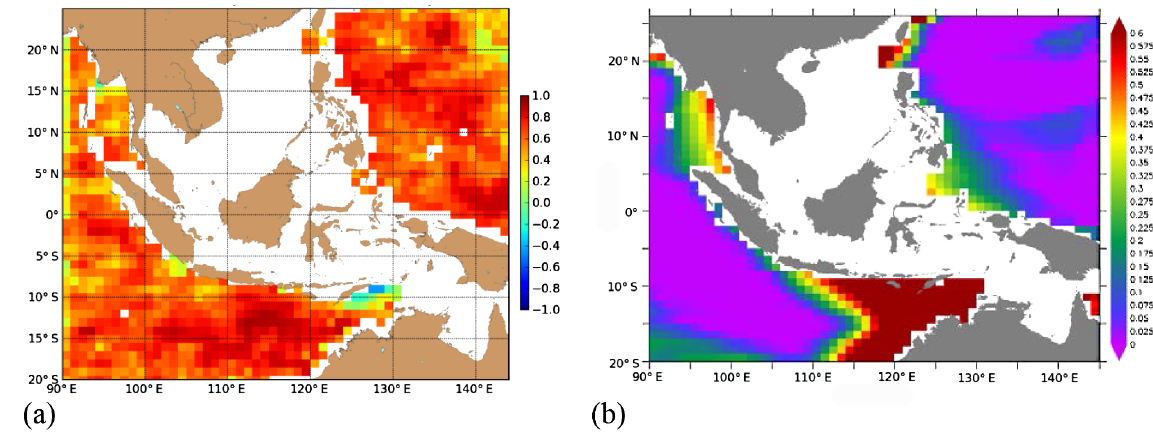
Figure 12. Mean temporal correlation between the (INDO12-AMSR-E) SST bias and the (INDO12-JAMSTEC) SST bias (a) and temperature interpolation error of JAMSTEC (ARGO + TRITON + CTD) (b) calculated from 2008 to 2010.